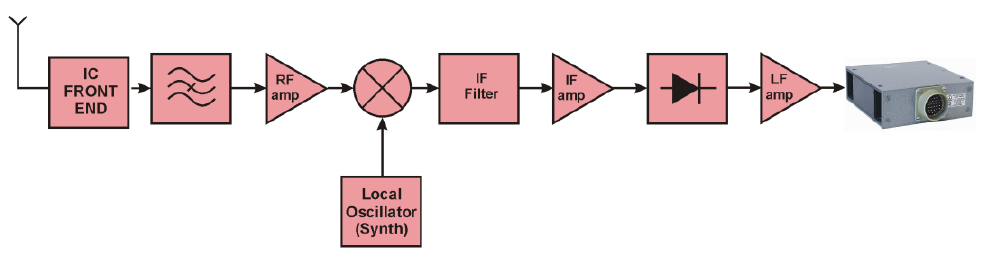
Figure 13. Superheterodyne receiver—simplified block diagram [5,14,20]. Selection and amplification of the desired signal at the tuned frequency ω D is the first part of the SHR at the RF front-end. The first block is a high-quality band-pass filter (BPF) with appropriate sensitivity and selectivity. The BPF circuit is responsible for the overall receiver’s selectivity and its ability to reject signals in close proximity to the desired frequency band. In most cases, the SHR embeds the RF tunable band-pass filter and RF amplifier. The signal at the output of the RF front-end is preprocessed to be converted in the frequency. The frequency converter is translated from the RF frequency band to the IF band by using the mixer and ω LO signal of the local oscillator—synthesizer. The result is the combined signals, which contain a large variety of signal characteristics such as the series of harmonics, according to the equation